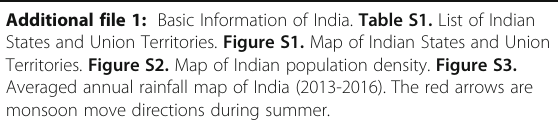
Territories. Figure S2. Map of Indian population density. Figure S3. Averaged annual rainfall map of India (2013-2016). The red arrows are monsoon move directions during